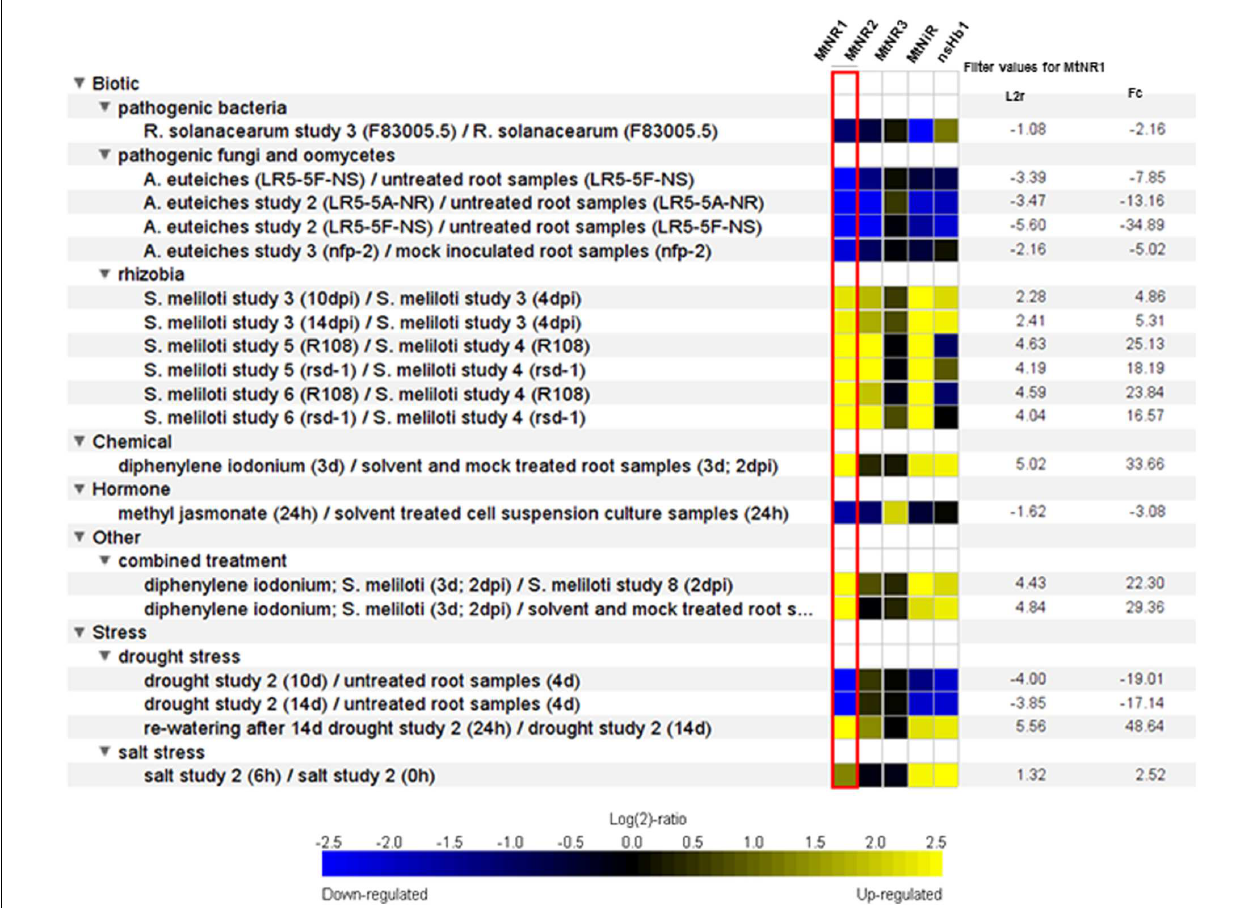
Frontiers in Plant Science |